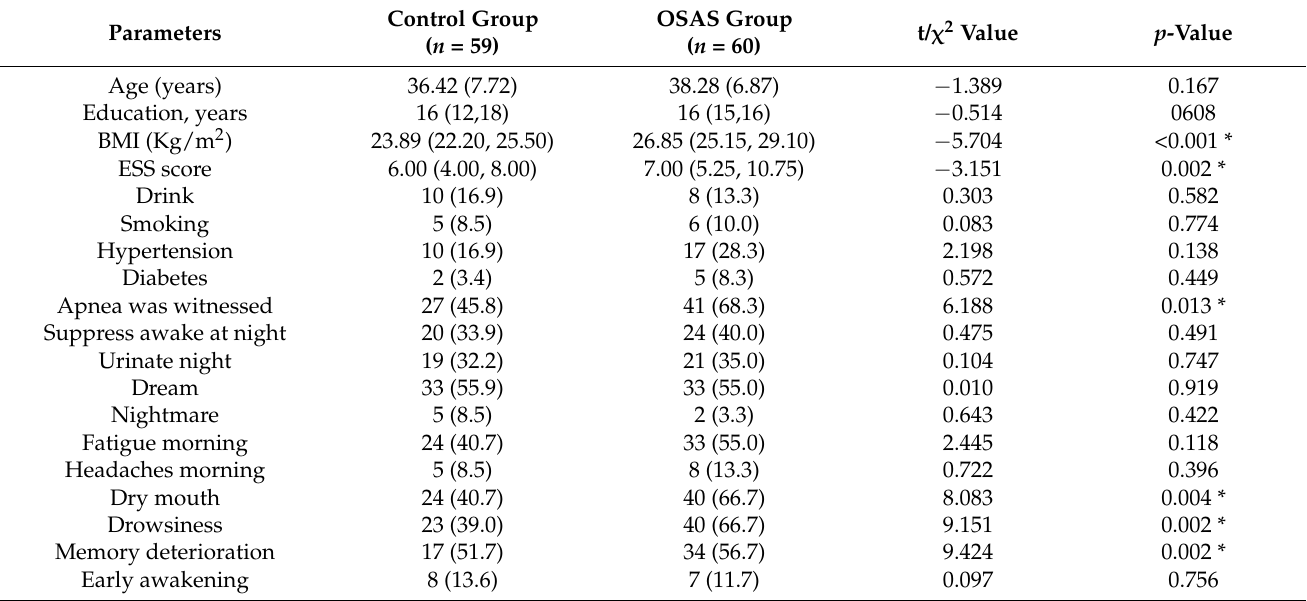
Table 1. Demographic and clinical characteristics.